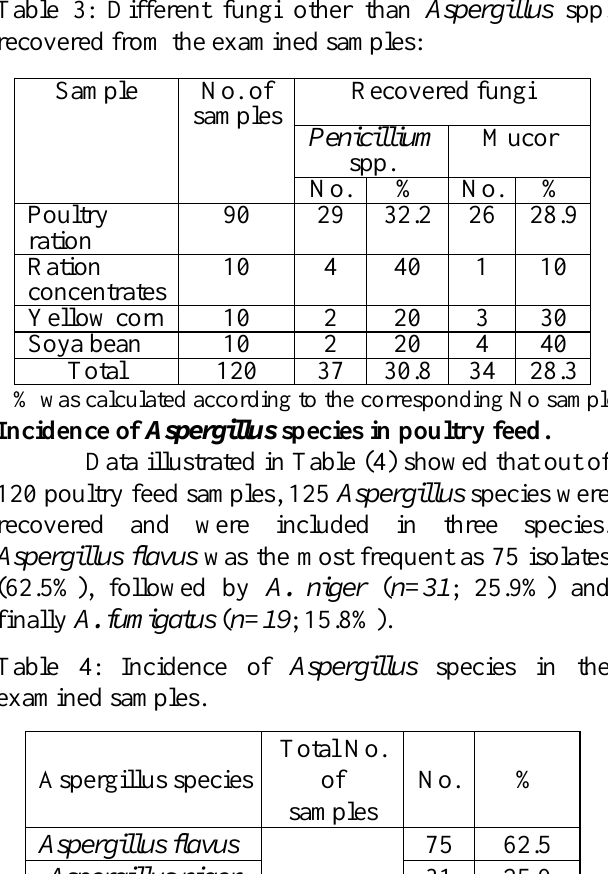
Table 3: Different fungi other than Aspergillus spp.